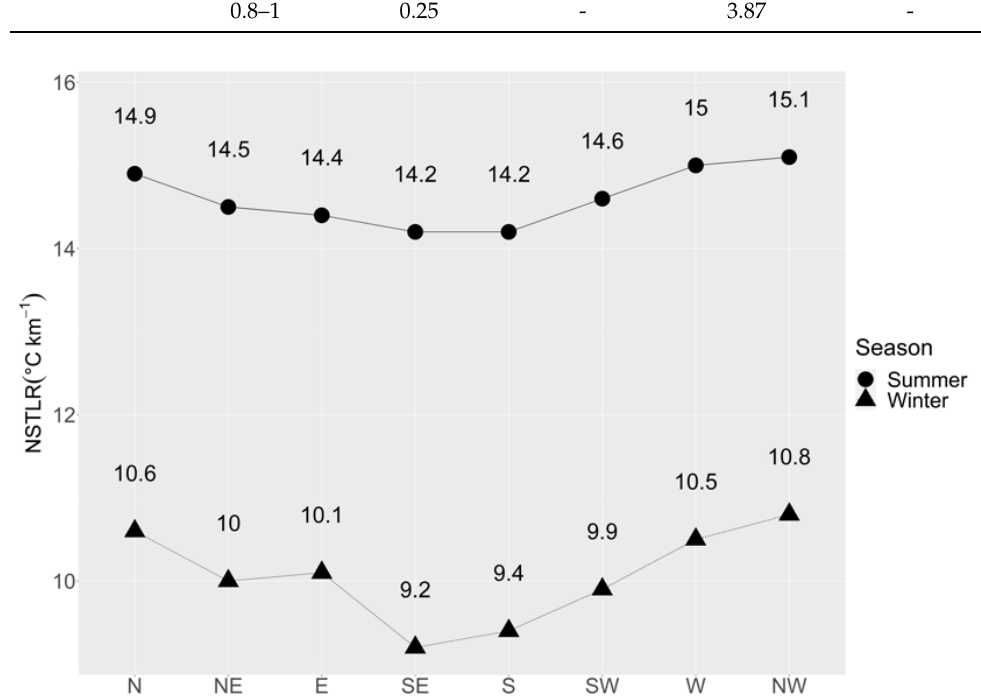
Figure 5. Temperature lapse rate of the two seasons against aspect. We utilized the LSZA equation to quantify the effect of solar position on the terrain slope at acquisition time, since the solar position changes the angle and intensity of the solar energy above the terrain [65,66]. NSTLR decreased with increasing LSZA for both seasons, possibly caused by a less direct impact of sunlight at higher LSZA, with a difference between seasons of more than 5 °C km −1 (Figure 6).